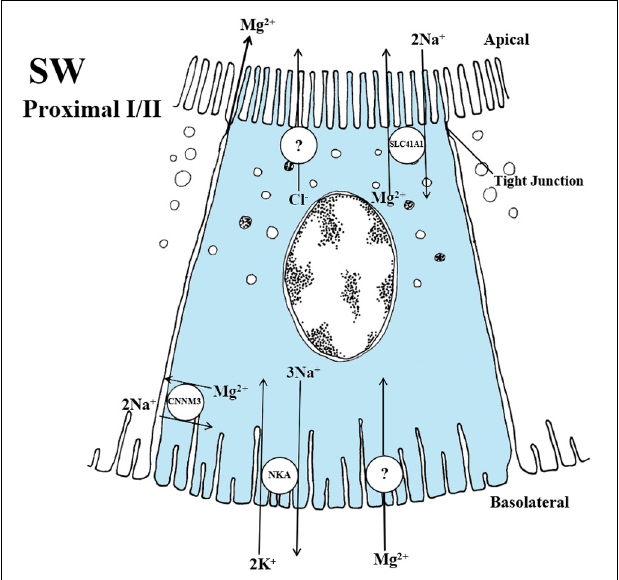
FIGURE 6 | Schematic overview showing localization and mechanisms of Mg 2 + transport in SW teleosts. The SLC41A1 have been localized to intracellular vesicles that are dispersed apically in the cell of proximal tubule I. In fish, the 2 Na + /Mg 2 + exchange rate has not been verified but has been demonstrated in the human model. The CNNM3 exhibits a lateral localization in both proximal tubules I and II. The specific exchange ratio of 2 Na + /Mg 2 + are again based on the human model whereas the function in fish is still speculative at this point. An apical Cl − channel that produce a lumen-negative transepithelial potential and a basolateral Mg 2 + channel for transport into the cell are necessary but yet not identified in the fish kidney. The CNNM2 has been linked to Mg 2 + reabsorption in FW fish however the mechanisms are so premature in the fish model that no overview has been given at this point. Models are based on the papers of Islam et al. (2013), Islam et al.